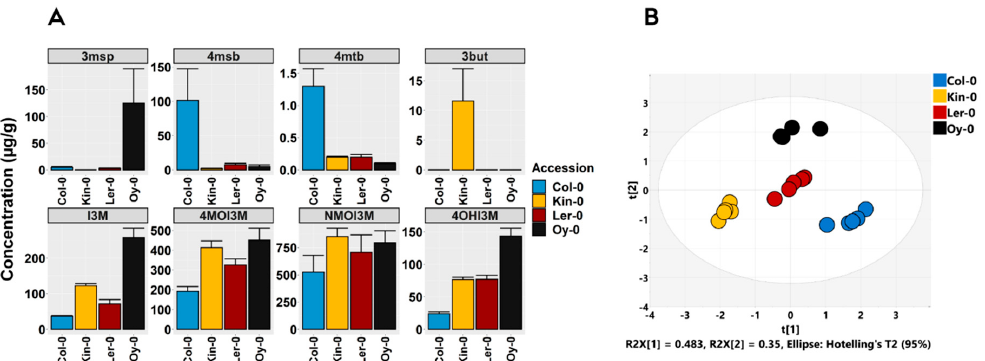
Figure 3. Composition and concentrations of aliphatic and indole glucosinolates in soil-grown Arabidopsis accessions (Col-0, Kin-0, Ler-0 and Oy-0) root extracts. ( A ) Concentration (µg/g dry mass). Error bars indicate standard error of the mean of five independent samples ( n = 5). ( B ) Principal components analysis (PCA) score plot based on glucosinolate concentrations of analyzed Arabidopsis root extracts. Different color denotes samples from different Arabidopsis accessions ( n = 5). The ellipse represents the Hotelling T-squared with 95% confidence. Full names and abbreviations: glucoraphanin (4msb), glucoerucin (4mtb), glucoiberin (3msp), gluconapin (3but), glucobrassicin (I3M), 4-methoxyglucobrassicin (4MOI3M), neoglucobrassicin (NMOI3M) and 4-hydroxyglucobrassicin